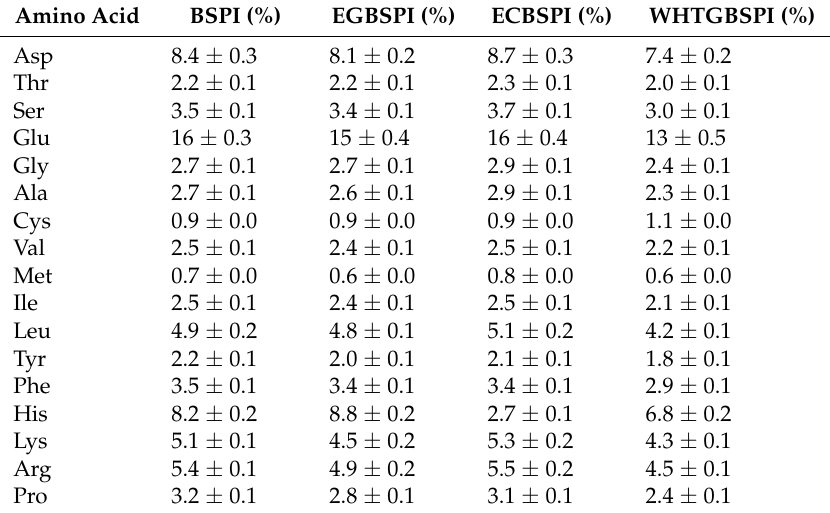
Table 1. Relative content of the amino acids of BSPI and its modified